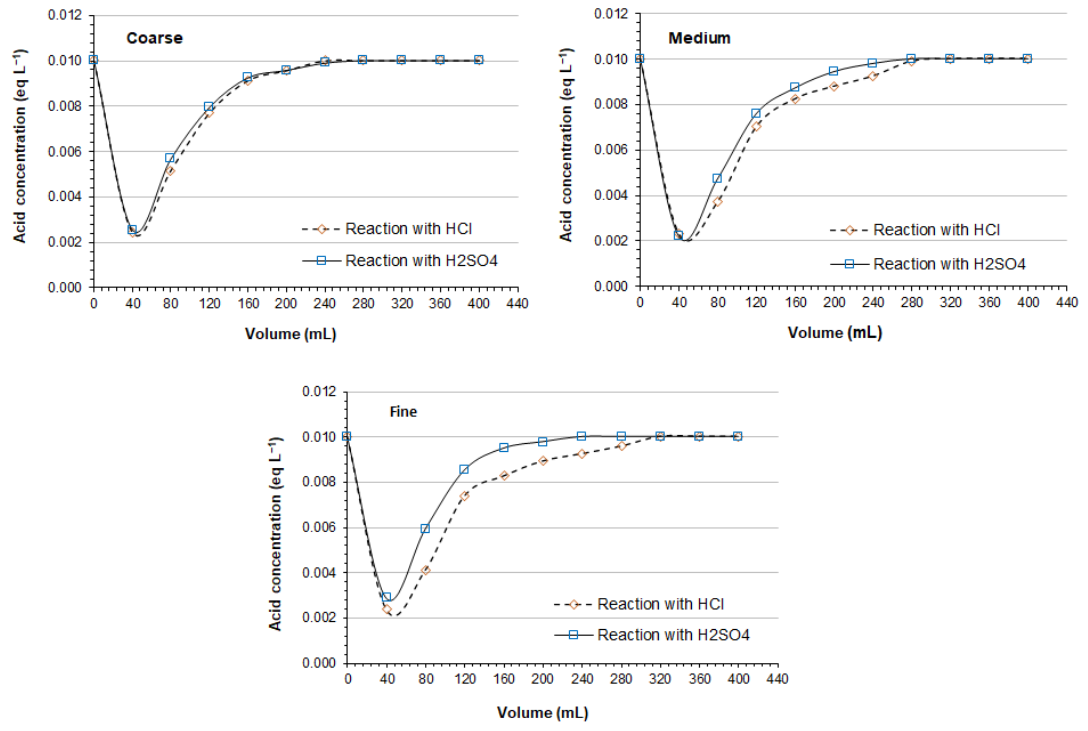
Figure 3. Evolution of the protonation reaction on the calcined substrates manufactured from the three particle-size fractions studied.